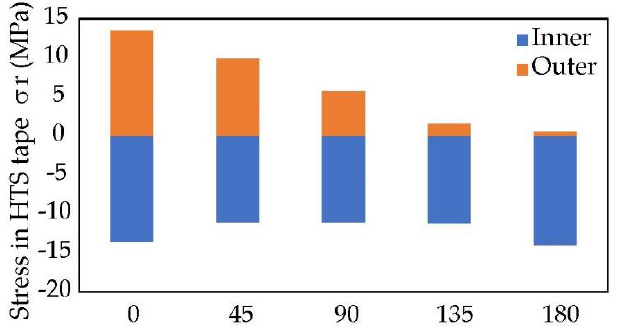
Figure 18. Stress in HTS tape during short-circuit. The SuperPower ® 2G HTS wire tolerates high stress up to 550 MPa. Above 550